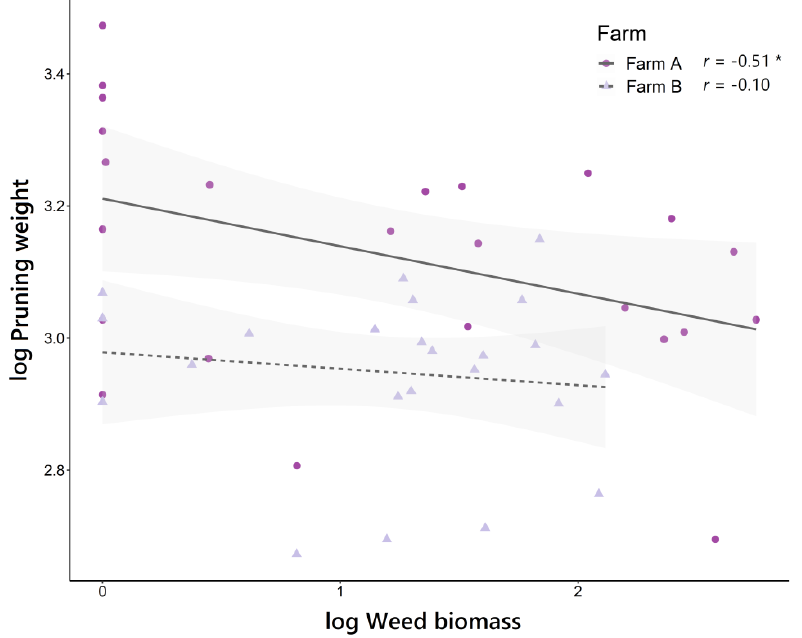
Figure 7. Correlation between weed biomass (log weed biomass) and grapevine vegetative growth (log Pruning weight) according to the factor “farm”. Spearman’s correlation coefficient ( r ) and significance level (no asterisks, non-significant; * p < 0.05) are indicated for each of the estimated correlations. Confidence intervals (95%) are shown with light-grey shaded areas.